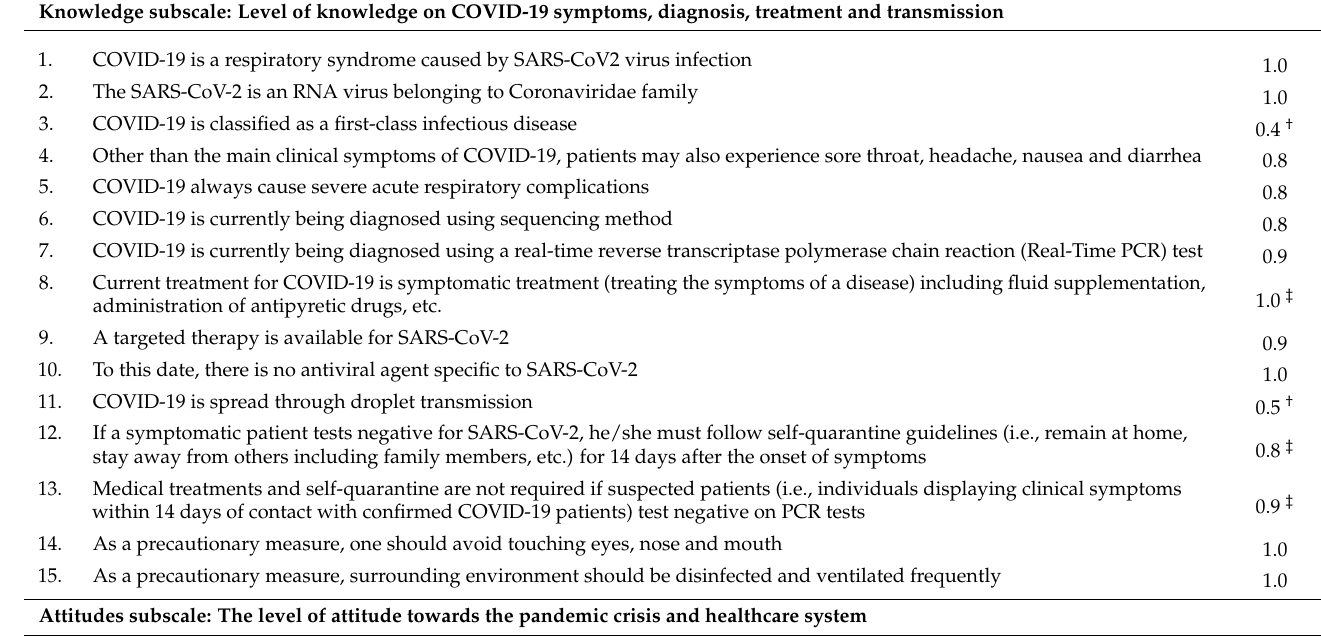
Based on the comments of the expert panel, two items with I-CVI values of 0.40 and 0.60 were excluded, three items were revised and 31 items were retained for construct validation (Table 2). After excluding two items with unsatisfactory I-CVI, the S-CVI/Ave and S-CVI/UA values of the 34 items were 0.96 and 0.65, respectively. Table 2. Content validity index (CVI) rating of the individual KAP COVID-19 items. Item